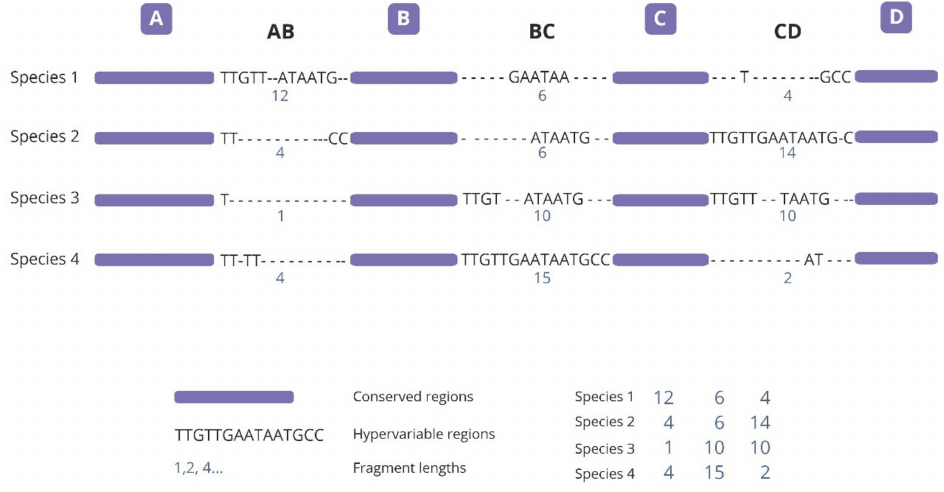
Figure 1. Schematic illustration presenting the strategy used in the species identification by the insertions / deletions method (SPInDel). Illustration shows the sequence alignment for four hypothetical species (1 to 4). Three hypervariable domains (dotted lines) are defined by four conserved regions (blue). The compartent of the alignment is developed to indicate the presence of a large number of gaps in hypervariable regions. Subsequent species are identified using the numerical profile caused by the combination of lengths in the hypervariable regions (blue numeric